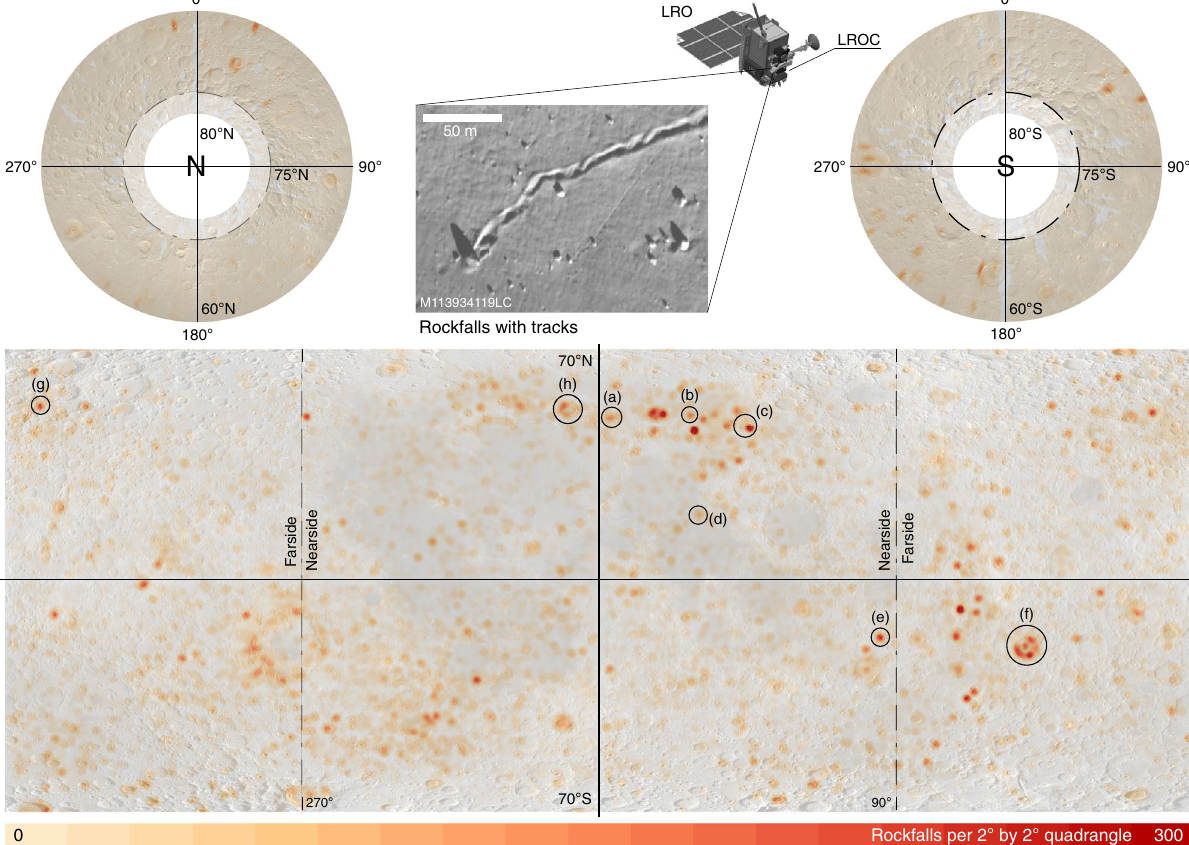
Fig. 1 Global rockfall distribution heat map. Heat maps of lunar global rockfall distribution in both equirectangular (70°N to 70°S) and polar projection (60°N to 80°N and 60°S to 80°S). Mapping results above 75°N and below 75°S might be less complete due to challenging illumination conditions (indicated by transparent white areas). Rockfall density is given in rockfalls per square degrees, i.e., the number of rockfalls per 2° latitude by 2° longitude quadrangle. The labeled black circles denote details shown in Fig. 2. Inset shows examples of rockfalls and their tracks with various sizes: detail of LRO NAC (LROC) image M113934119LC. Global WAC mosaic in the background 40 . NAC image credits to